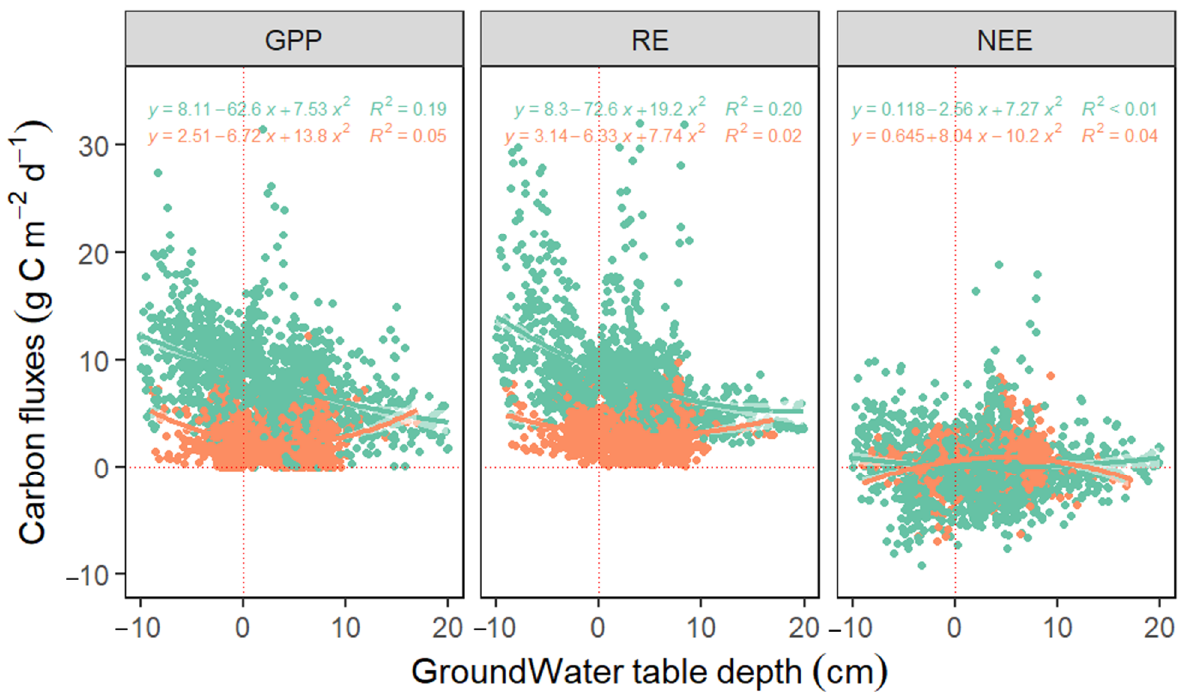
Figure 4. Linear relationships between groundwater table depth (GWT) and gross primary productivity (GPP), ecosystem respiration (RE), and net ecosystem exchange (NEE) during the growing (green circles and equations) and non-growing seasons (orange circles and equations) from 2009–2019. Daily data was used in the analysis.